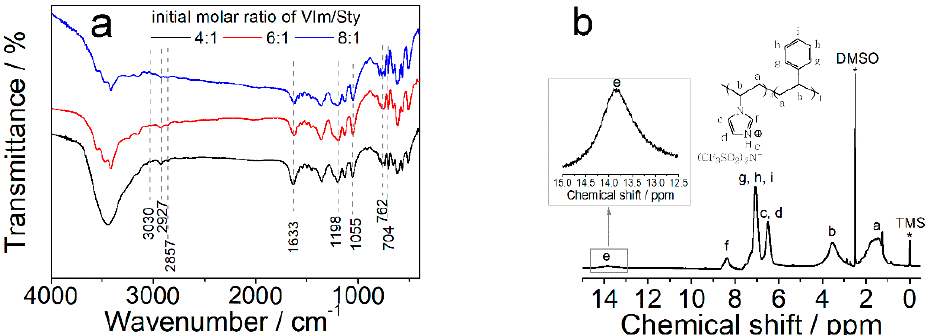
Figure 2. ( a ) Fourier transform infrared (FTIR) spectra of PS 1 -b-P(VImH + ) n TFSI with different molar ratio of initially added monomers (VIm / Sty). ( b ) 1 H NMR spectrum of PS 1 -b-P(VImH + ) 4 TFSI.